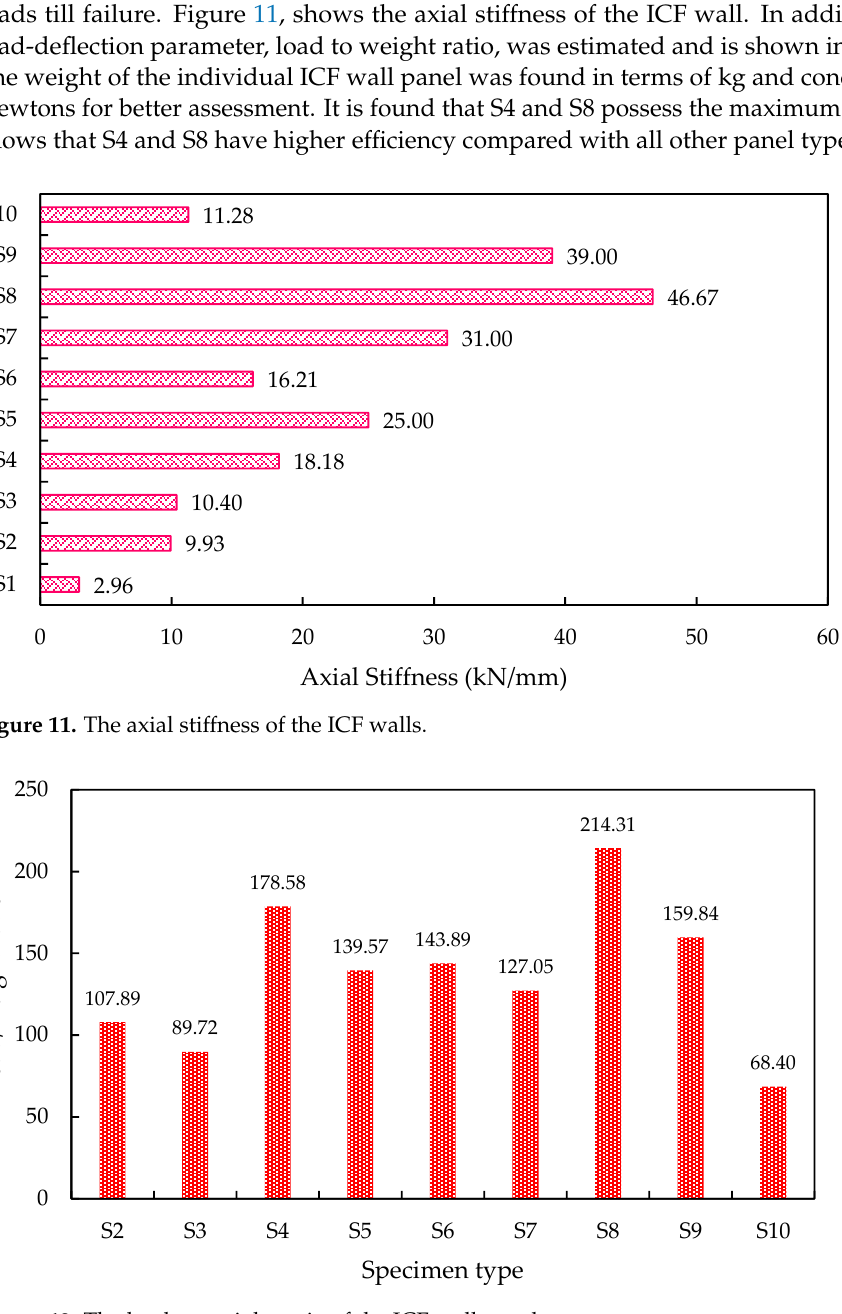
Figure 12. The load-to-weight ratio of the ICF wall panels.